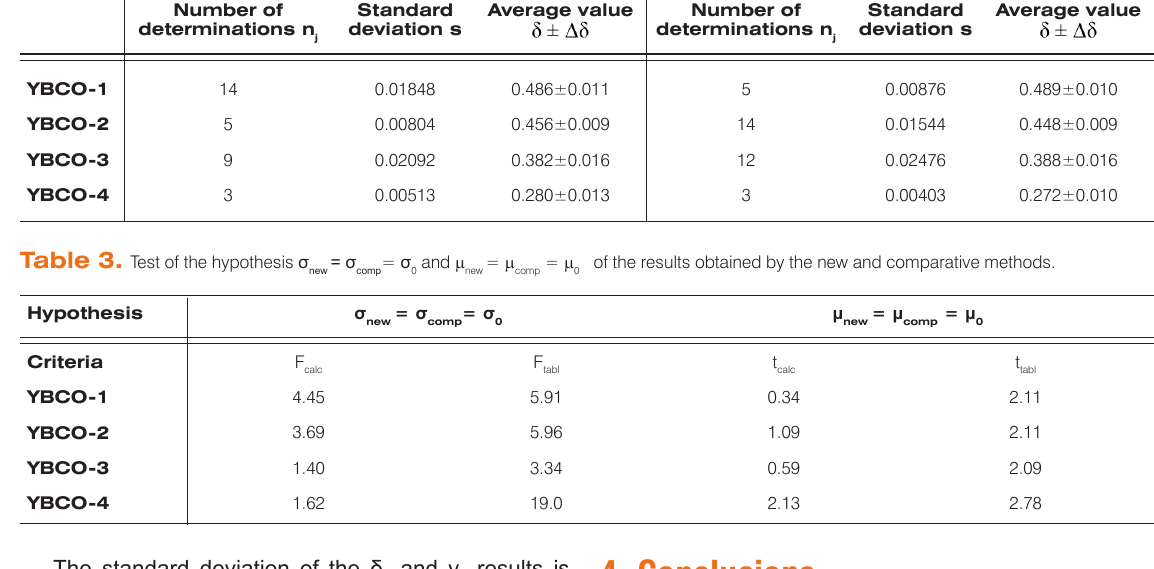
Table 2. Results from YBCO bulk samples analysis, obtained by the new and comparative [15] methods.